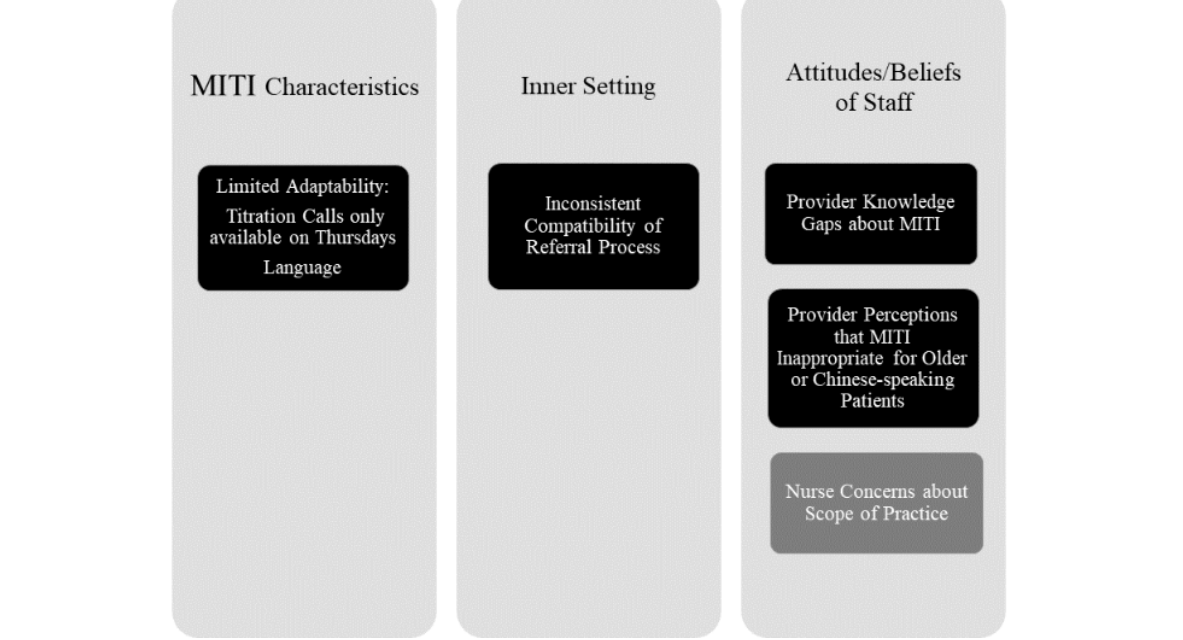
Barriers: Characteristics of Mobile Insulin